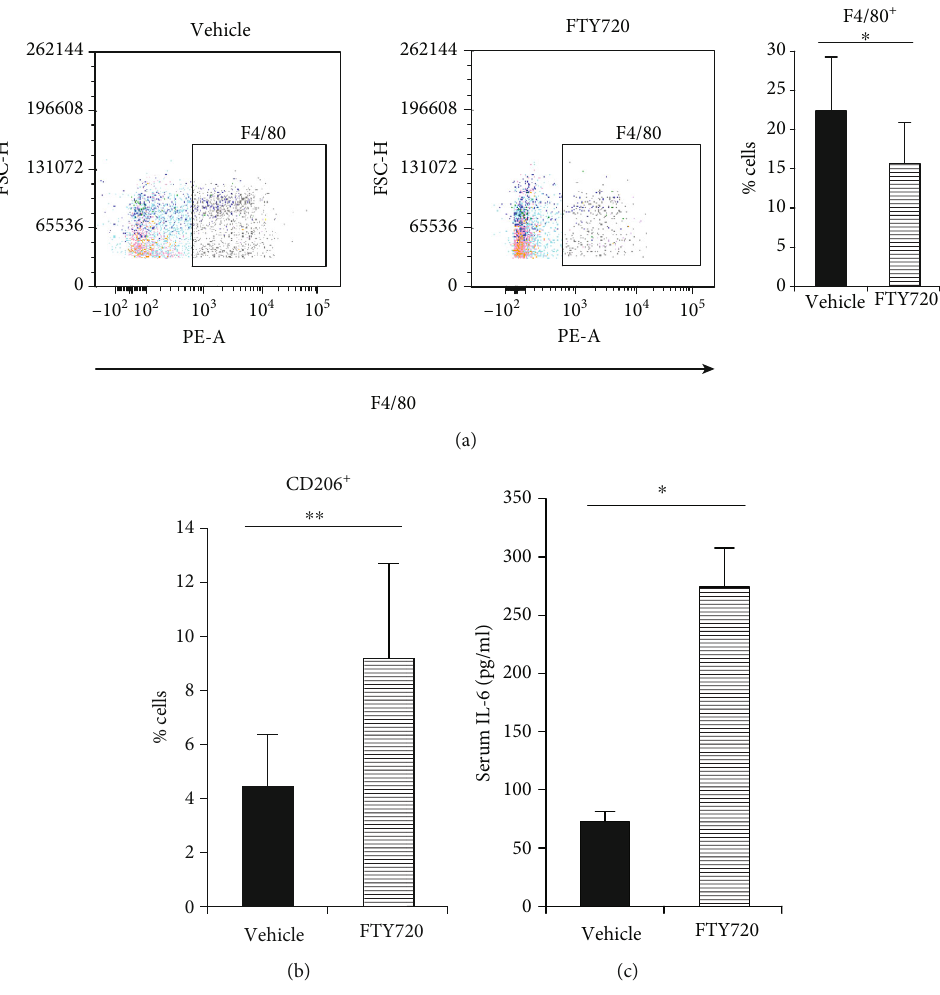
Figure 2: E ff ect of topical FTY720 injection on Day 14 scar macrophage frequencies and M1/M2 polarization. (a) Representative fl ow cytometric plots are shown along with the average frequencies of F4/80 + cells. (b) The percentages of CD206 + cells were determined by fl ow cytometry ( n = 7 ). Two independent experiments were performed. Both showed similar results. (c) The level of serum IL-6 was determined by ELISA ( n = 4 ). All values shown represent means ± s : e : m : ∗ p < 0 : 05 and ∗∗ p < 0 : 01 , as determined by Student ’ s t -test or Welch ’ s t -test after F